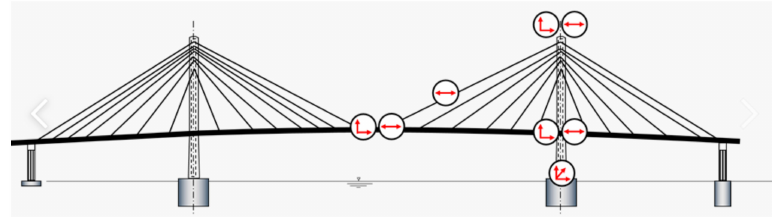
Figure 6. Location of the installed seismic accelerometers on the reference bridge.